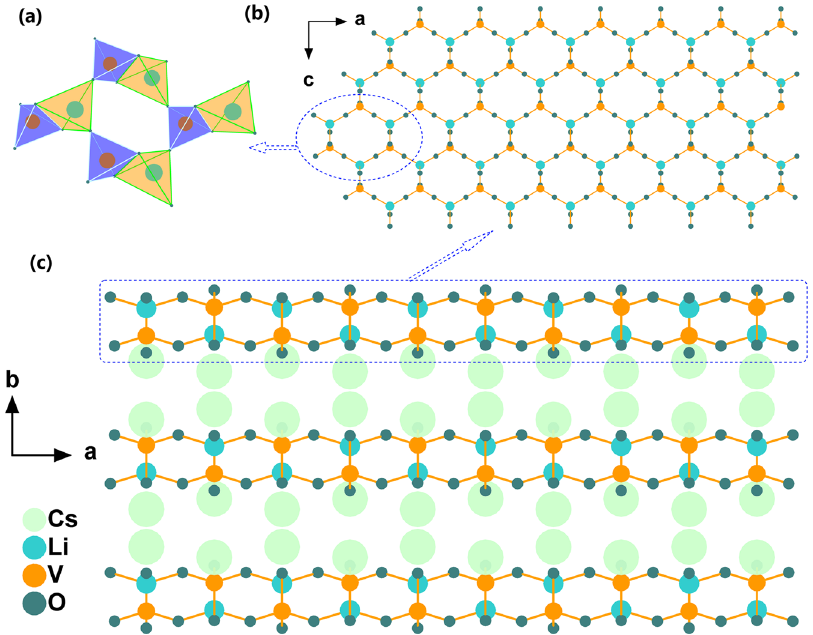
Figure 3. Crystal structure of CLVO. ( a ) Coordination environment of the LiO 4 and VO 4 tetrahedra; ( b ) The 2D [LiVO 4 ] ∞ layers viewing along the b axis; ( c ) The 3D crystal structure of CLVO. (LiO 4 tetrahedra: yellow; VO 4 tetrahedra,